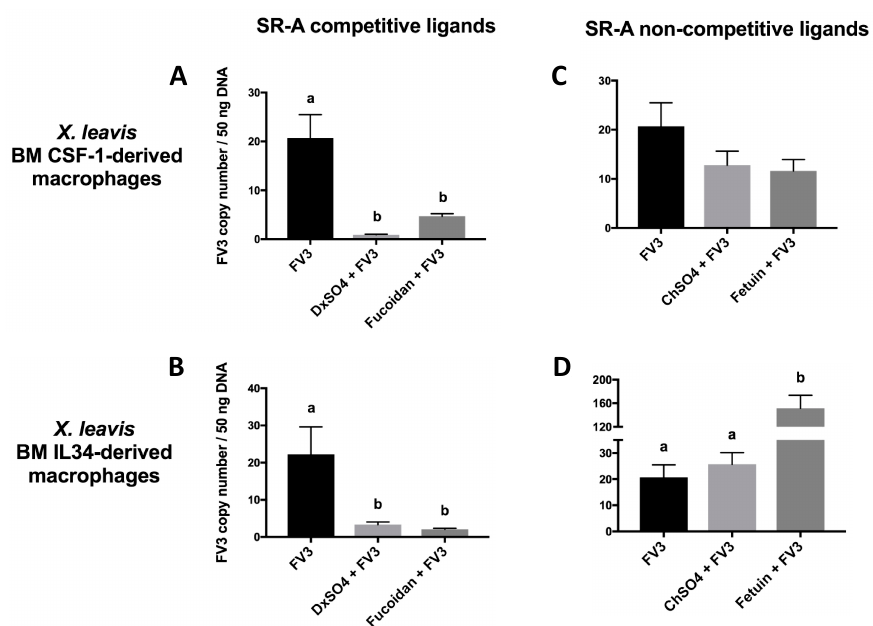
Figure 2. Effects of SR-A competitive and non-competitive ligands on the cell-associated FV3 load in X. laevis CSF-1 M φ s and IL-34 M φ s. The X. laevis CSF-1 M φ s and IL-34 M φ s were derived by culturing adult frog bone marrow cells with recombinant CSF-1 or IL-34, respectively, for 5 days. The M φ s were then pre-treated with 200 µ g/mL of the SR-A competitive ligands (DxSO 4 , fucoidan) ( A , B ) and non-competitive ligands (ChSO 4 , fetuin) ( C , D ) for 1 h and challenged with FV3 (MOI of 0.5) for 2 h. The FV3 DNA viral loads were determined by absolute qPCR. The results are presented as means ± SEM ( n = 3–5). Statistical analysis using a one-way ANOVA test and Tukey’s multiple comparisons test with 95% confidence intervals was performed. p values less than 0.05 are considered statistically significant. Groups with different letters are statistically different from one another.